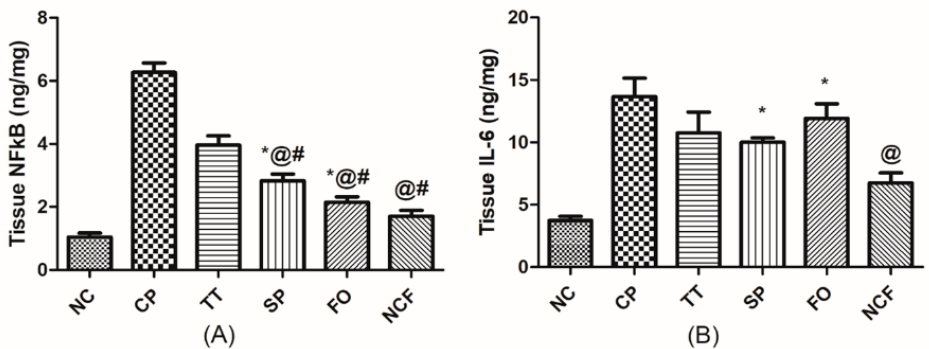
Figure 13. Effect of TT, SP, FO, and NCF on cisplatin-induced alterations in testicular inflammatory status in adult male rats. Effect of 20 days administration of TT (100 mg/kg/orally); SP (1000 mg/kg/orally); FO (400 mg/kg/orally); and new nutraceutical formula (NCF) at a dose of (4.4 g/kg/orally) on testicular content of ( A ) NF- κ B and ( B ) IL-6 in CP-untreated rats. Values are means of 6-10 rats ± SD. Statistical analysis was performed using one-way ANOVA followed by Newman Keuls multiple comparison tests ( p < 0.05). As compared with normal control (NC; *), cisplatin (CP; @), Tribulus terrestris (TT; #). Spirulina platensis (SP), Fish oil (FO), Nuclear Factor-Kappa B (NF- κ B), Interleukin 6 (IL-6).